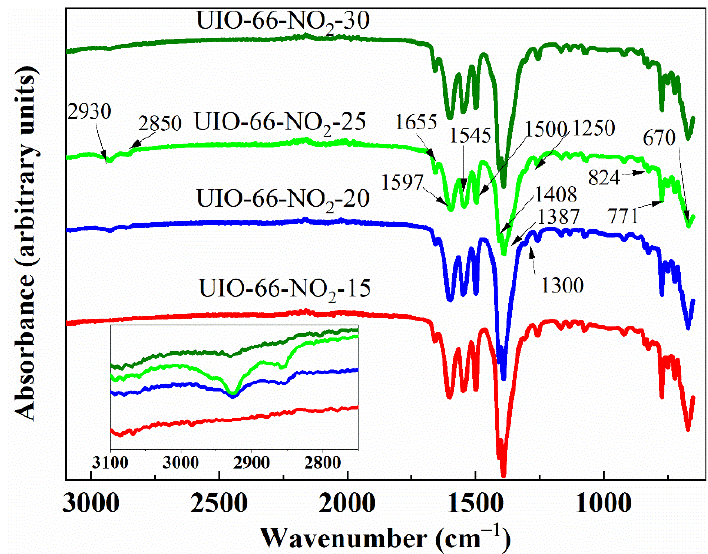
Figure 3. FTIR spectra of UIO − 66 − NO 2 − X. Table 2. Assignments of the FTIR peaks of UiO-66-NO 2 -X.